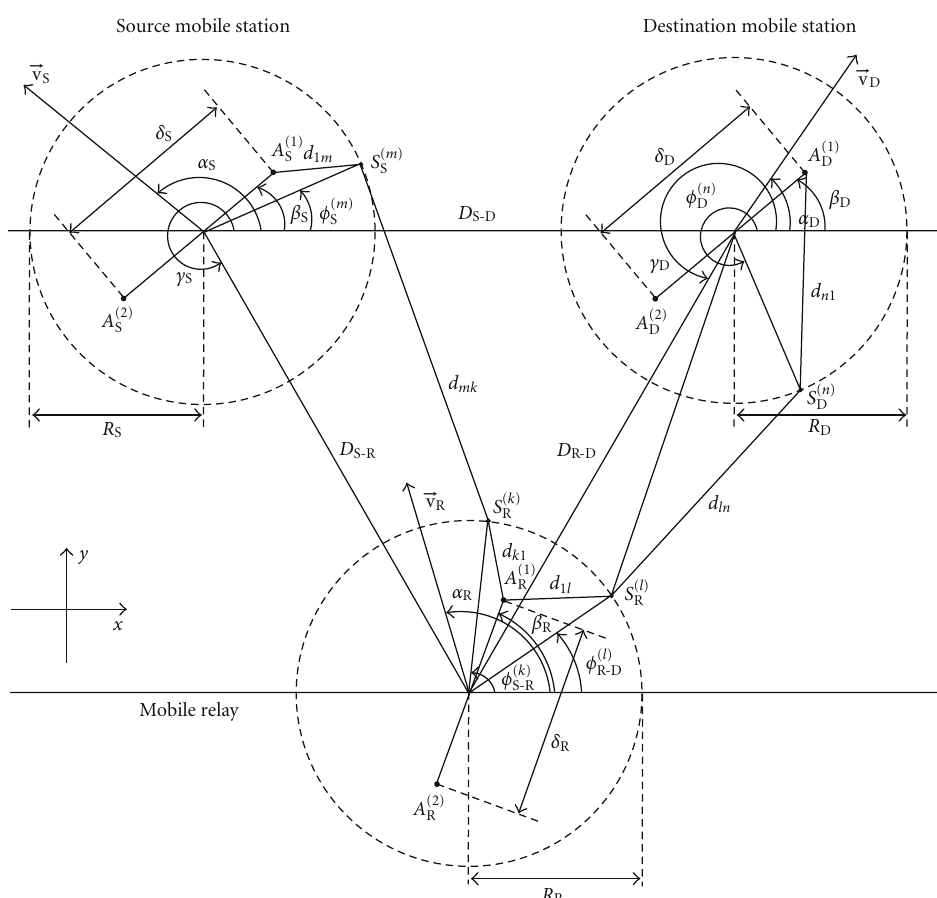
Figure 1: The geometrical three-ring scattering model for a 2 × 2 × 2 MIMO M2M channel with local scatterers on rings around the source mobile station, the mobile relay, and the destination mobile station.